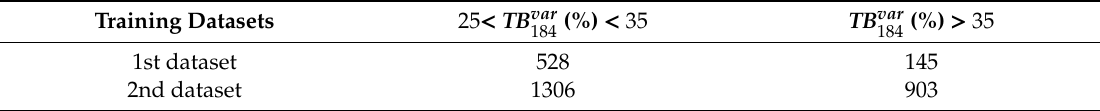
Table 5. Number of training data for the hail detection model.